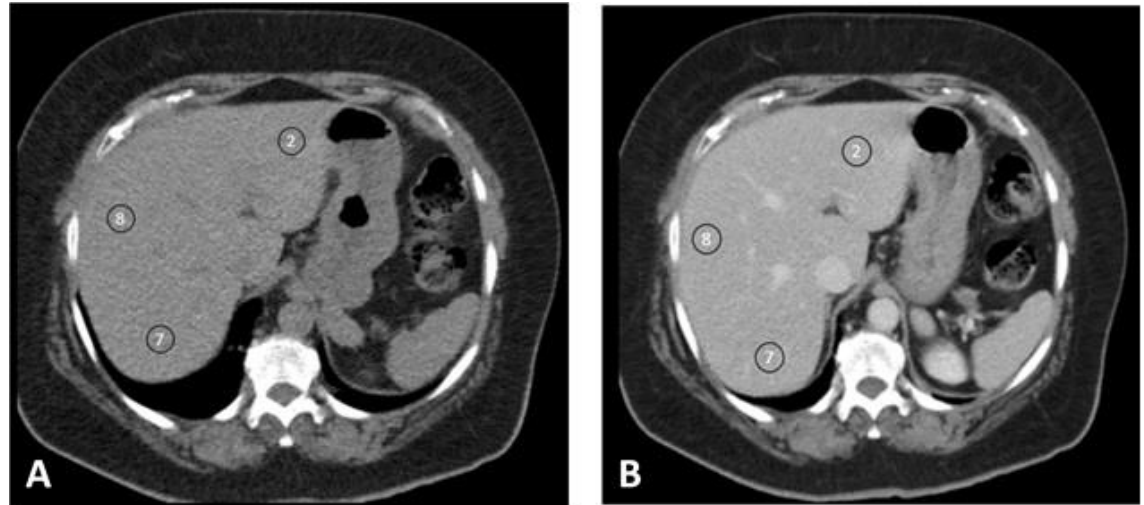
Figure 2. Region of interest (ROI) placement according to the Couinaud segmental classification to measure liver enhancement. ROIs were drawn in S2, S8, and S7 of the liver (when available) in unenhanced and enhanced images (portal venous phase). The degree of enhancement (ΔHU) was calculated by subtracting the unenhanced enhancement values ( A ) from enhanced enhancement values ( B ).